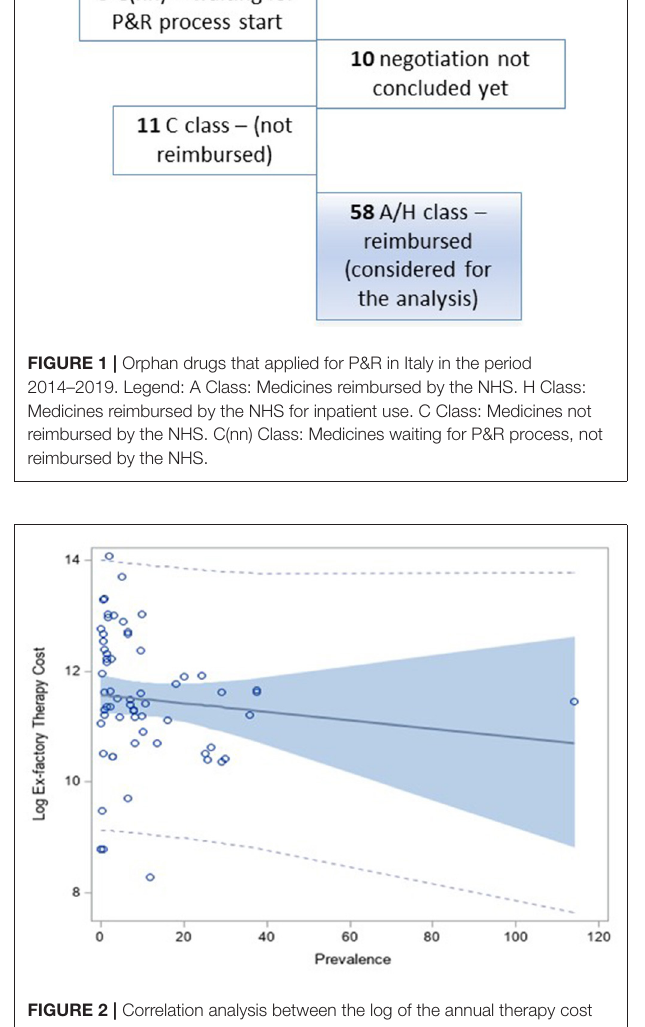
Therefore, the application of the MEAs did not improve the correlation with the prevalence.